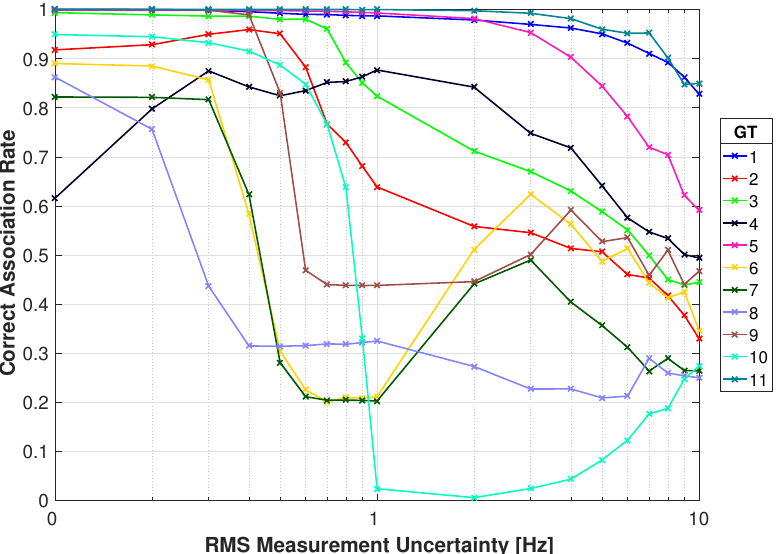
Figure 17. Correct association rate for matching specific cellular emanation measured by the constellation of RF receivers with the corresponding target from the multi-spectral video tracker using the RMSD DD.